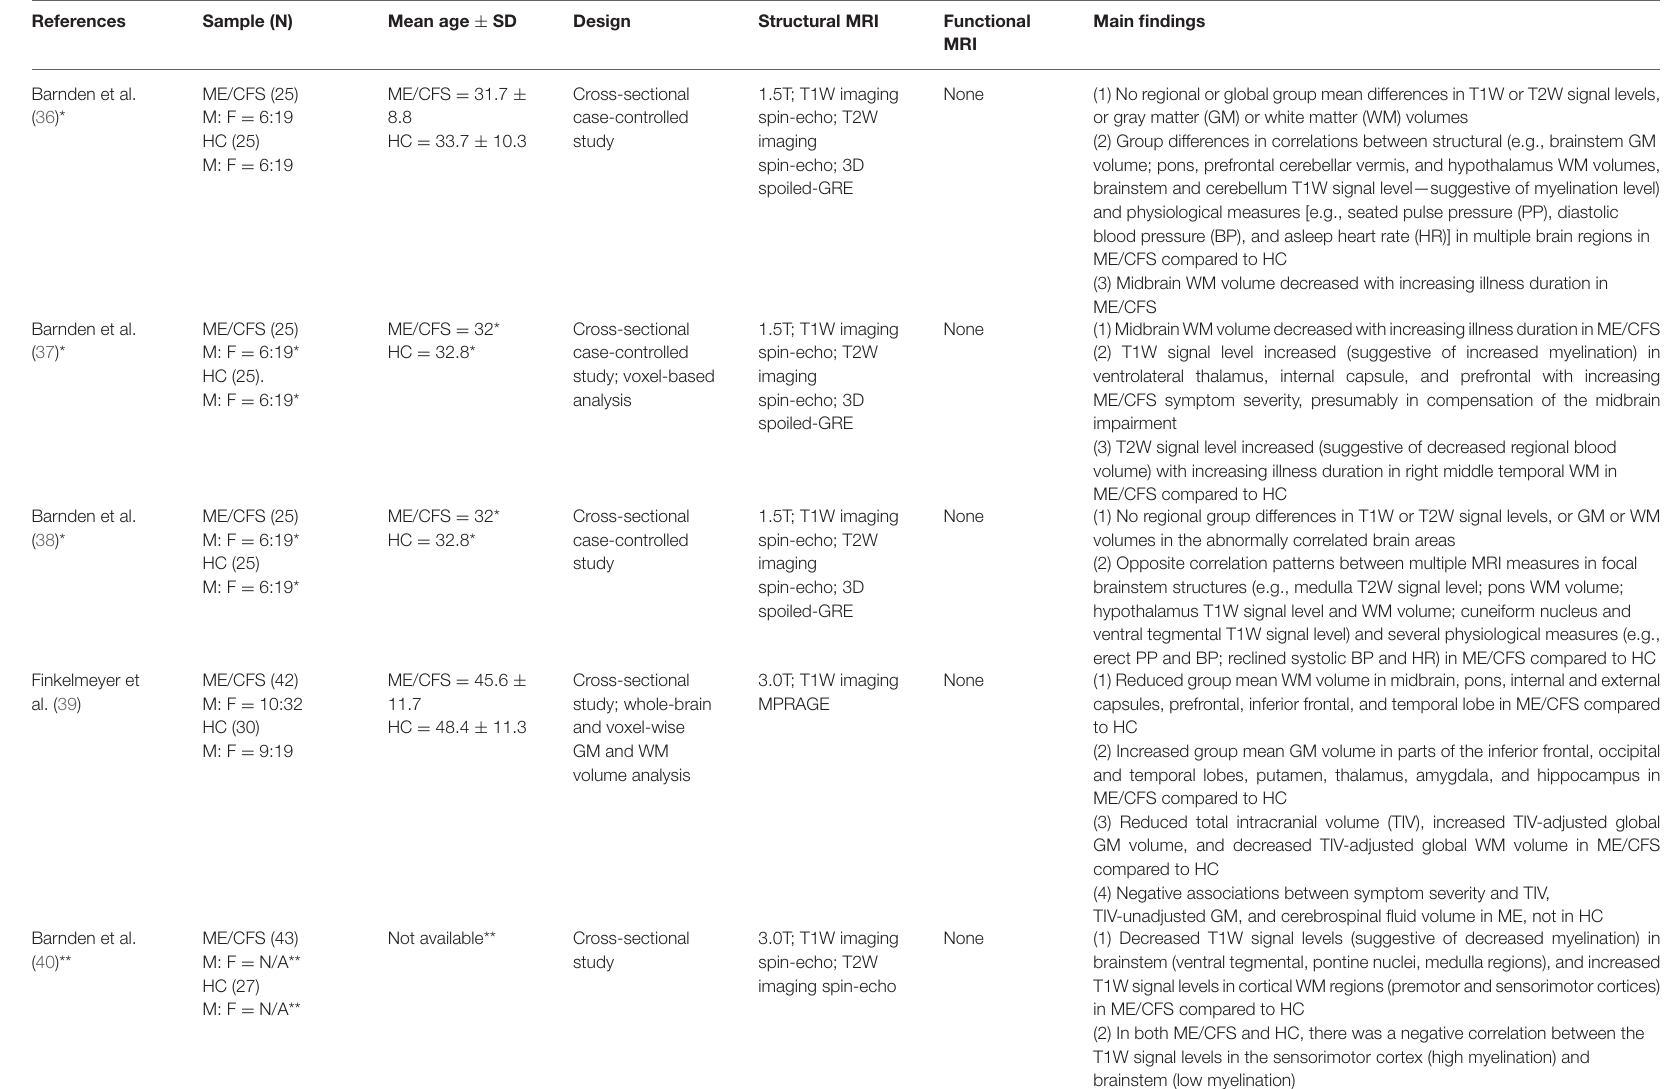
TABLE 1 | MRI studies investigating the role of the brainstem in myalgic encephalomyelitis/chronic fatigue syndrome (ME/CFS).